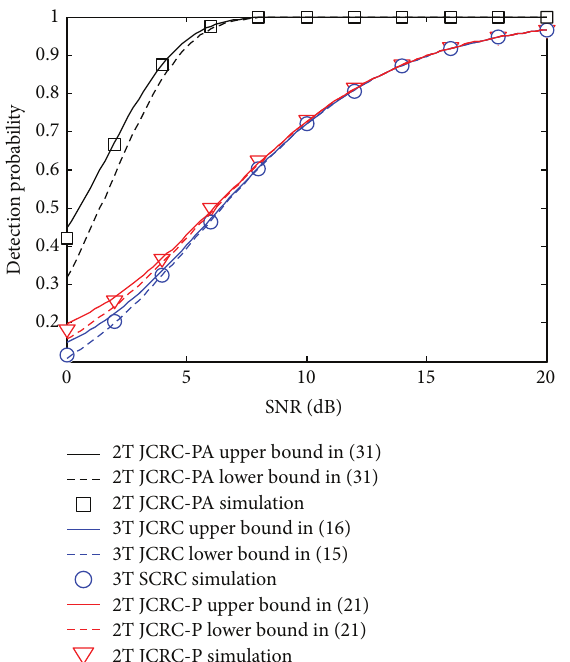
Figure 2: Detection probability comparison of JCRC and SCRC.